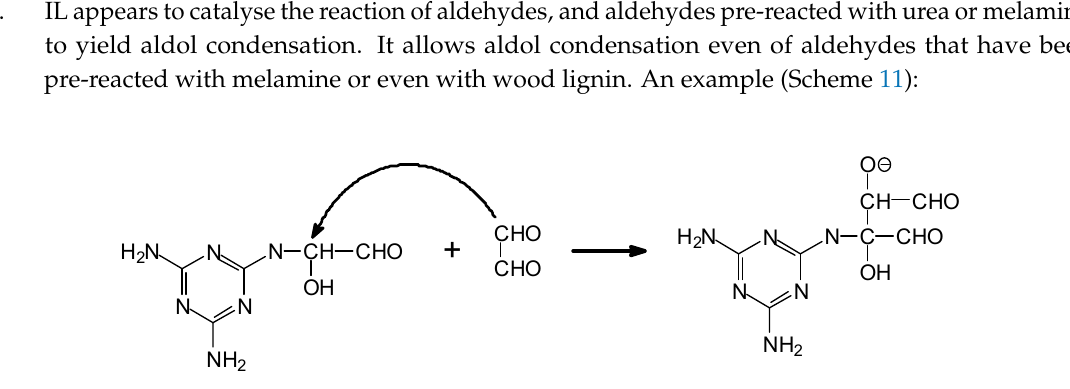
Scheme 10. Glyoxal ether bridges formed by water elimination between two melamine molecules.